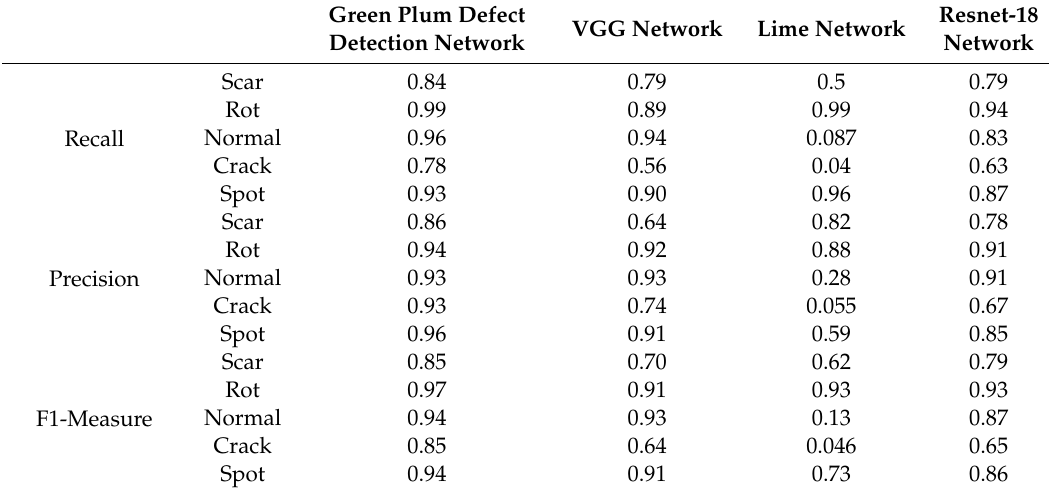
Table 5. Network